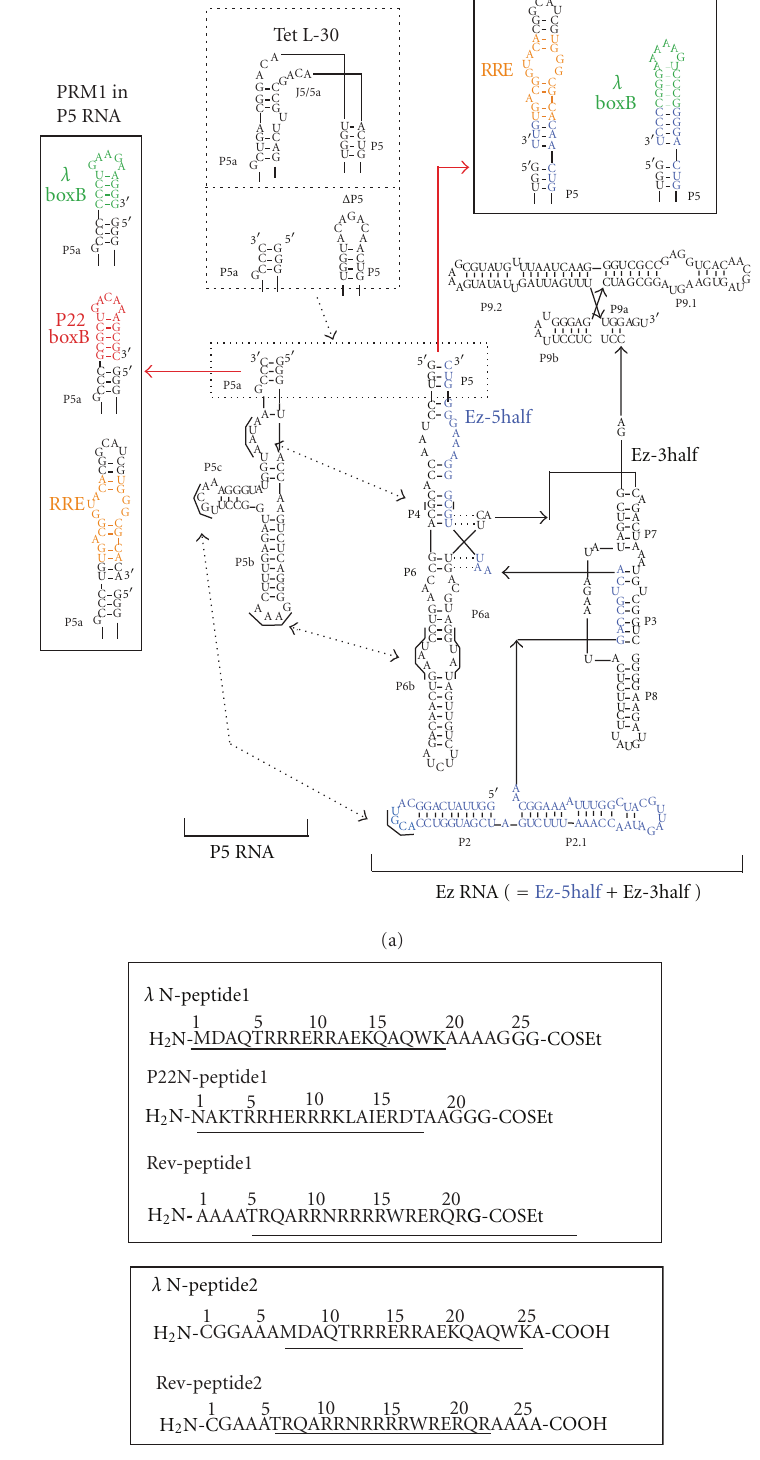
Figure 2: A peptide ligation system with the two-piece Tetrahymena RNA template. (a) Secondary structures of the unimolecular Tetrahymena intron RNA (Tet L-30) and its two-piece derivatives. Boxes with dotted lines indicate P5/P5a elements at which the parent Tet L-30 was separated to produce a two-piece derivative (P5: Ez). Dashed arrows indicate the tertiary interactions assembling the P5 and Ez RNA. Boxes with solid lines indicate peptide recognition modules (PRM1 and PRM2) introduced in the P5 RNA and Ez RNA, respectively. (b) Aminoacid sequences of substrate peptides employed for chemical ligation. Underlines indicate the sequences directly responsible for binding with their target